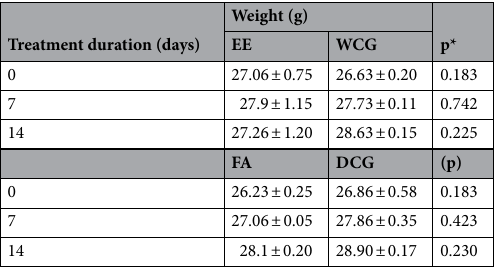
Table 1. Weight of mice treated with ethanolic extract or fraction of alkaloids from Aspidosperma nitidum. EE ethanolic extract, FA fraction of alkaloids, WCG water control group, DCG DMSO control group (99% water + 1% DMSO). * p value was obtained by Student’s T-test, comparing EE versus WCG, or FA versus DCG.